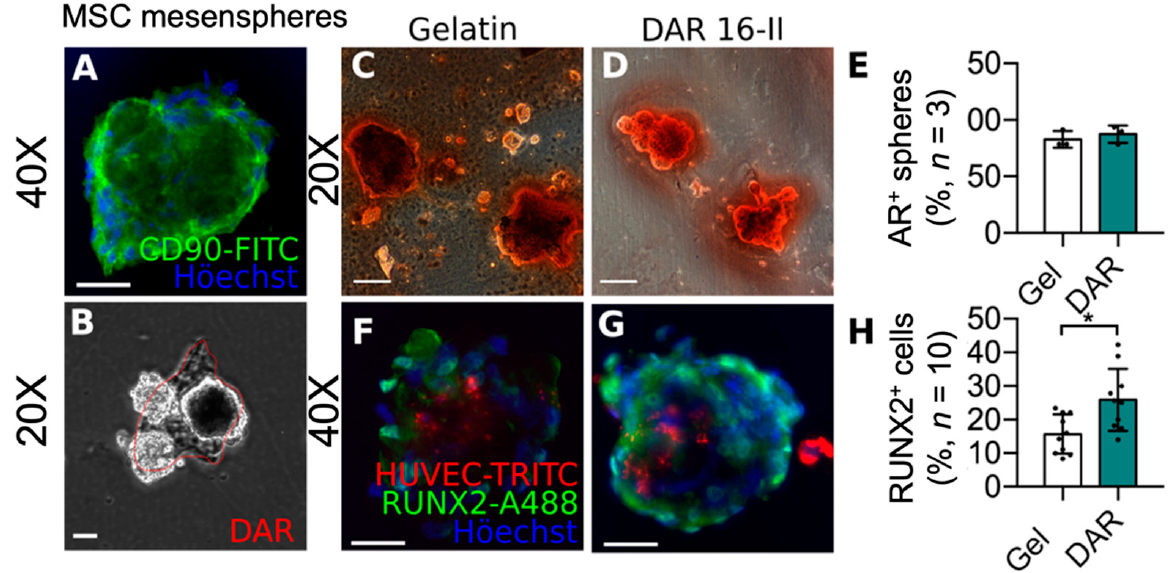
Figure 3. ( A ) Expression of the mesenchymal stem cell marker CD90 on freshly generated mesen- spheres (40 × OM, scale-bar = 100 µ m); ( B ) representative picture (20 × OM, scale-bar = 100 µ m) show- ing mesenspheres’ adhesion to DAR 16-II; ( C , D ) representative pictures (20 × OM, scale-bar = 100 µ m) of Alizarin red-stained mesenspheres grown under osteogenic conditions; ( E ) average number of alizarin positive spheres (average of three independent experiments counting twenty spheres for each experiment); ( F,G ) representative pictures (40 × OM, scale-bars = 100 µ m) of RUNX2 immuno-stained mesenspheres; ( H ) percentage of RUNX+ cells/mesensphere (average of ten spheres from three independent experiments). * p < 0.05